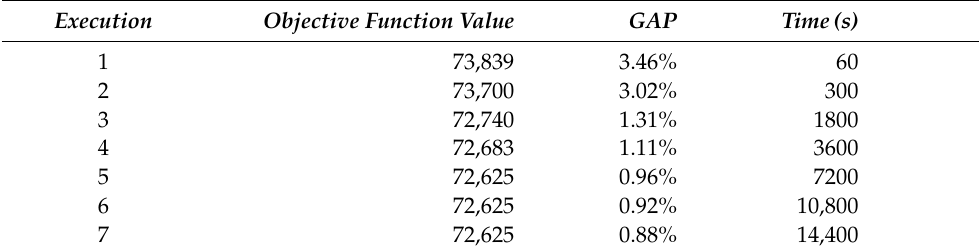
Table 6. Analysis of the GAP evolution of the solution computed for the case study.